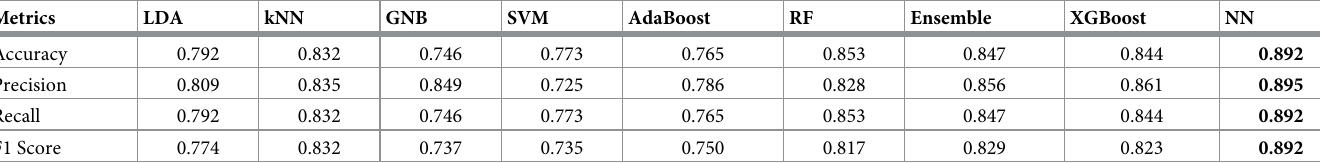
Table 4. Classification accuracy obtained using all handcrafted and radiomic feature combinations. Metrics